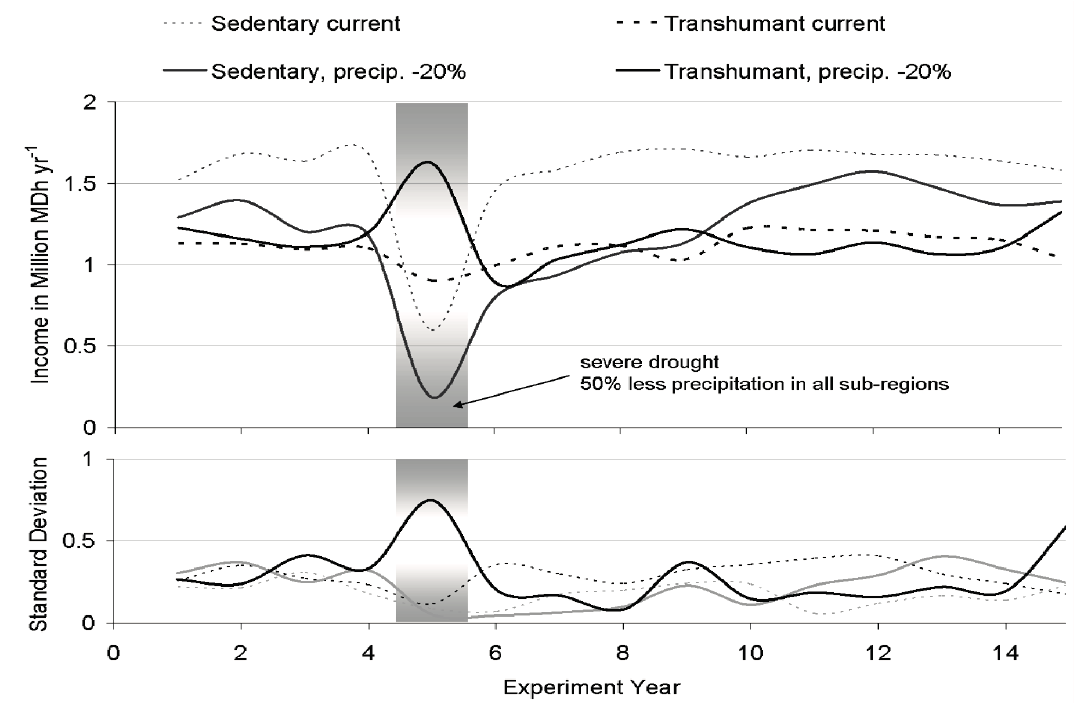
Figure 8. Ensemble mean (N = 15) of annual income from sedentary and transhumant pastoralism in the study region (top); standard deviation below; a severe drought occurs in year five of the experiment. Fodder and pasture allocation scenario as most probable for present day conditions (see Figure 6); income in million Moroccan